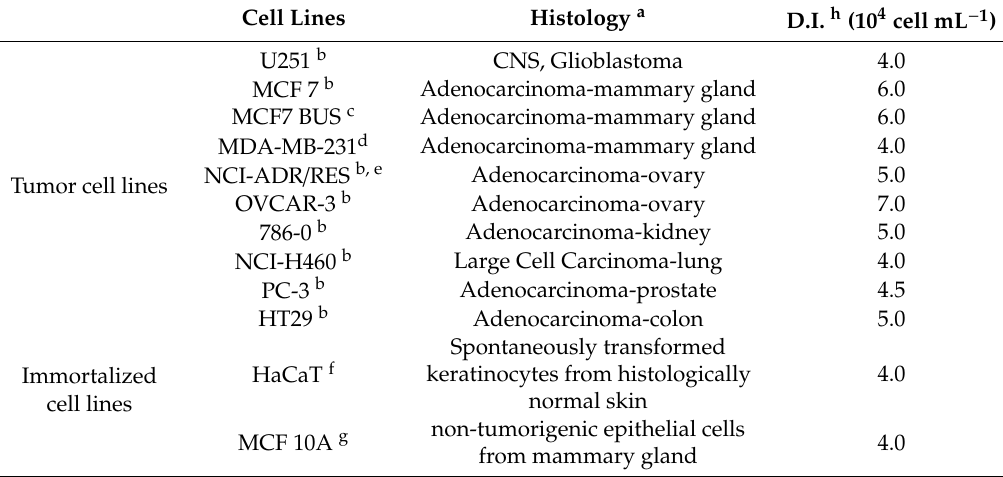
Table 1. Human tumor and non-tumor cell lines used in in vitro